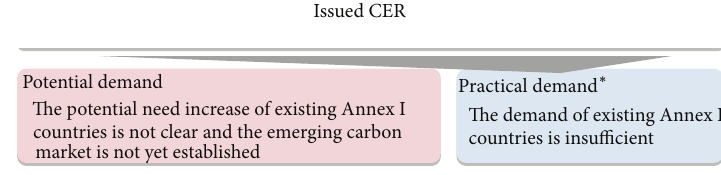
Figure 3: Relative excess scenario of current